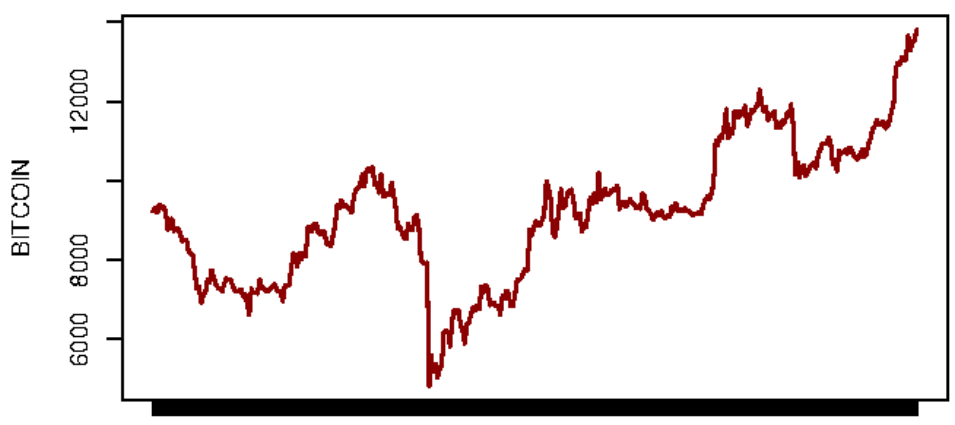
Figure 4. Price of Bitcoin (BTC)—CoinMarketCap.